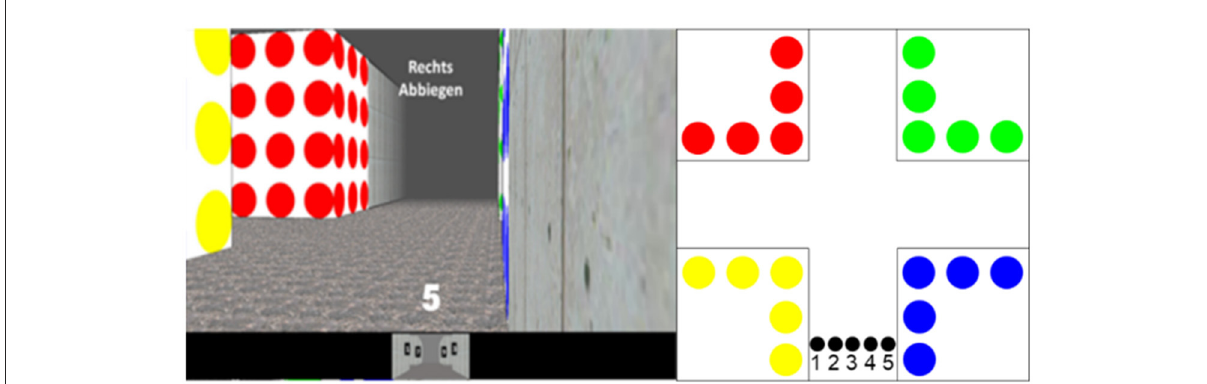
FIGURE9 (Left) An example of an intersection in the virtual environment of Experiment 4. (Right) Illustration of the five positions “far-left” (1), “half-left” (2), “middle” (3), “half-right” (4), and “far-right” (5). The participants were standing at one of the five positions. Direction instructions were again presented centered in the scene. In the present example, participants had to turn right (“rechts abbiegen”) and hence were positioned either “far in the direction of the turn” (5), “halfway in the direction of the turn” (4), “in the middle of the street” (3), “halfway in the opposite direction of the turn” (2), or “far in the opposite direction of the turn” (1). The simulated distances from the walls was 1.38m for the middle position, and for the more extreme positions about 0.92 and 0.46m to the left and right, respectively.